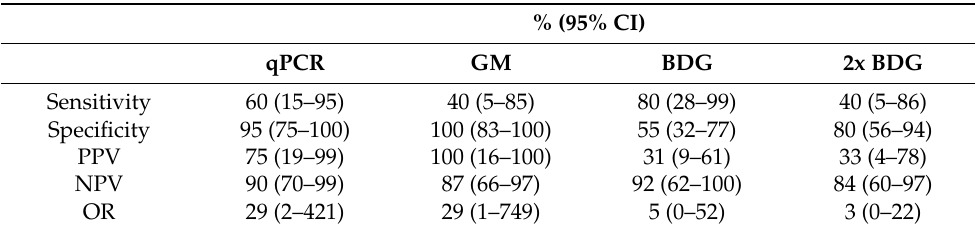
Table 2. Clinical performance in probable IA and possible IFD cases. PPV and NPV, positive and negative predictive value, respectively; OR, odds ratio; CI, confidential interval; 2x BDG, 2 consecutive tests were considered as positive.